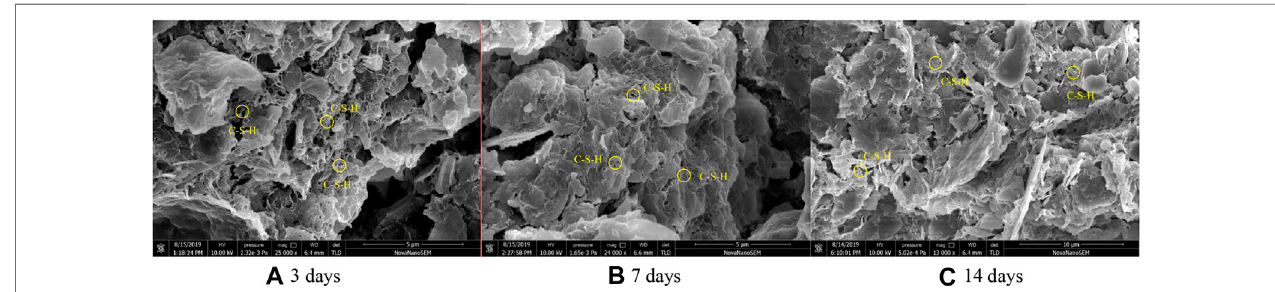
FIGURE 8 | SEM image of the one-part geopolymer-stabilized soft clay with 100% GGBFS and 0% FA at 5.42 mol/L NH solution: (A) 3 d; (B) 7 d; (C) 14 d.